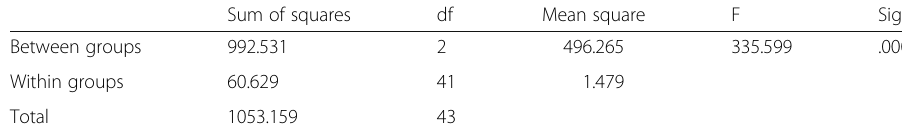
Table 2 One- way ANOVA on the groups ’ performance on the UGJT as post-test Sum of squares